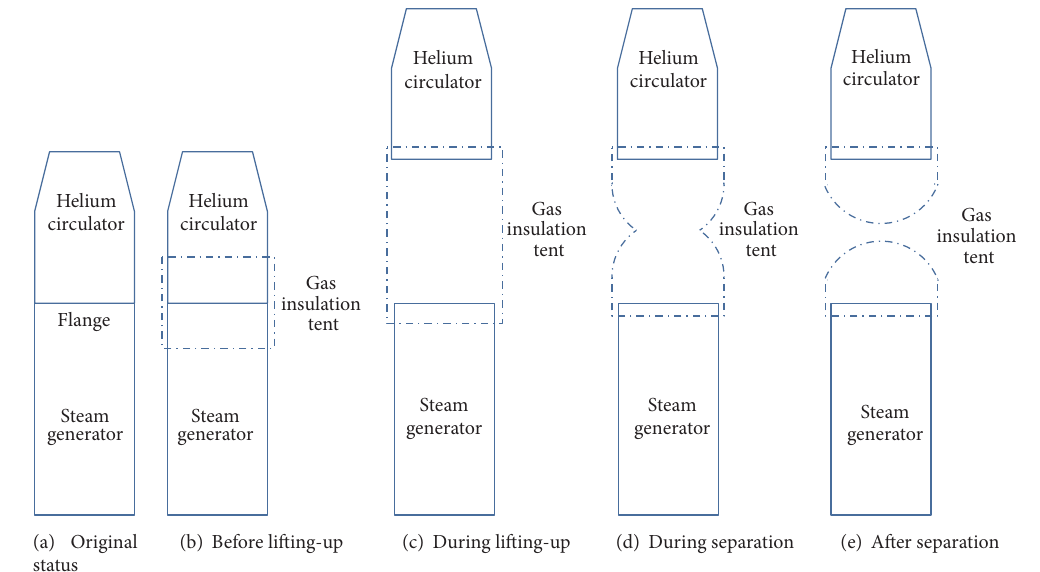
Figure 3: The gas insulation during the removal of the helium circulator.